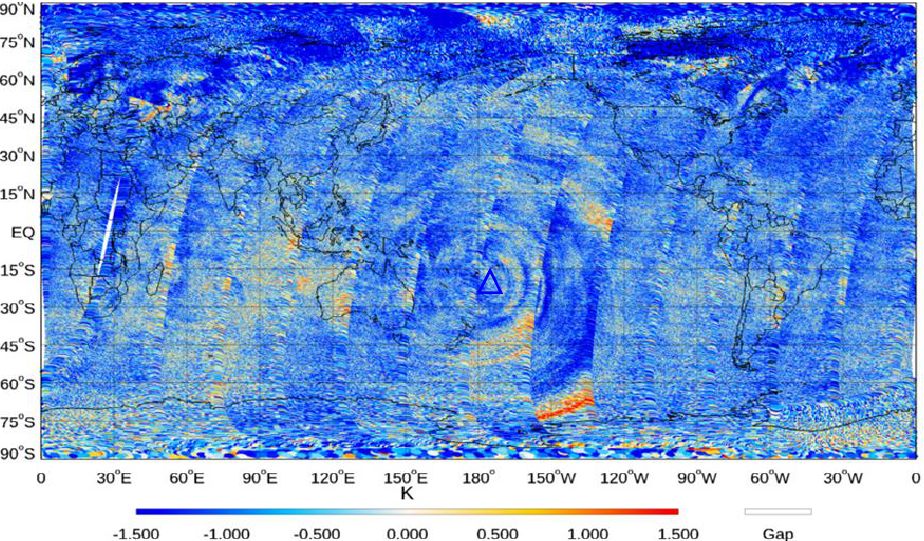
Figure 4. NOAA-20 ATMS TDR Channel 13 O − B global bias map at descending node on 15 January Figure 4. NOAA- 20 ATMS TDR Channel 13 O−B global bias map at descending node on 15 January 2022.